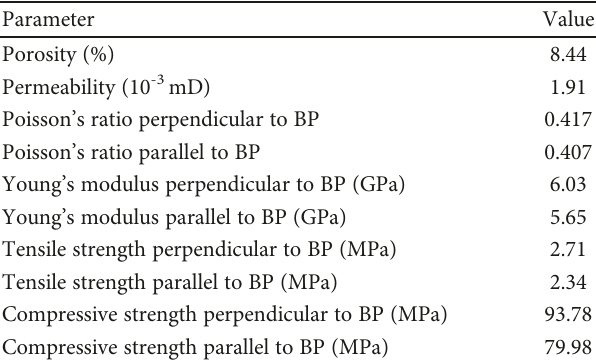
Table 1: Petrophysical properties of the testing